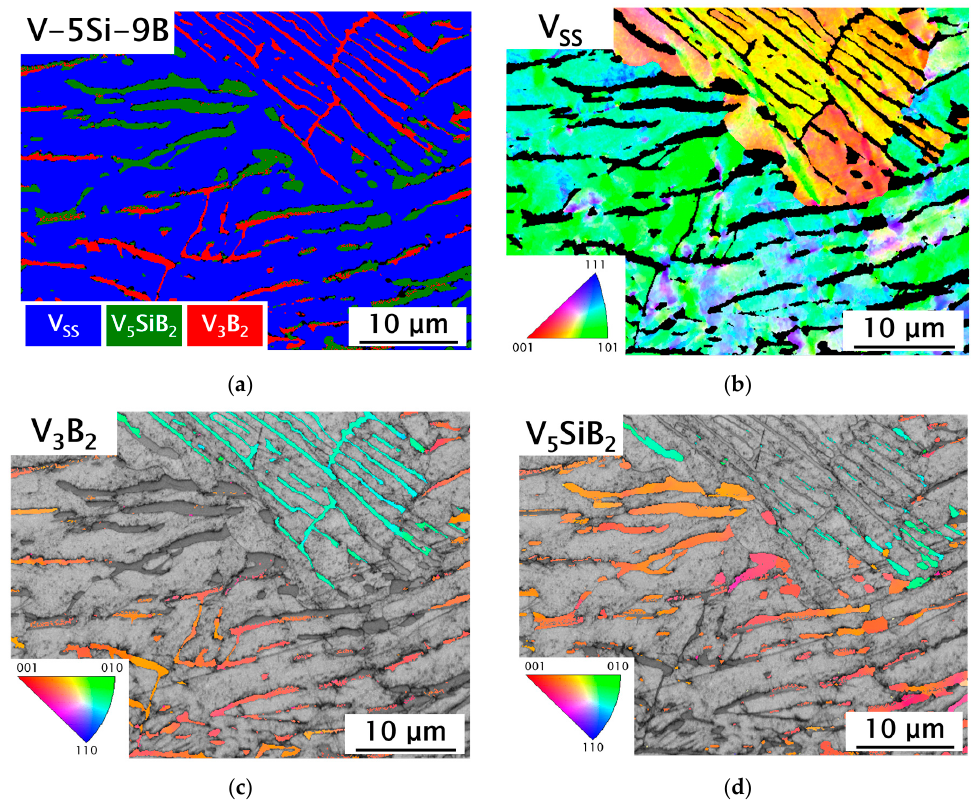
Figure 7. Electron backscatter diffraction ( EBSD) phase and orientation maps of deformed V ‐ 5Si ‐ 9B (15kV, step size = 0.088 μ m): ( a ) phase map of V ‐ 5Si ‐ 9B; orientation maps (inverse pole figure colored, in sample normal direction) for ( b ) V SS (vanadium solid solution phase); ( c ) V 3 B 2 ; ( d ) V 5 SiB 2.